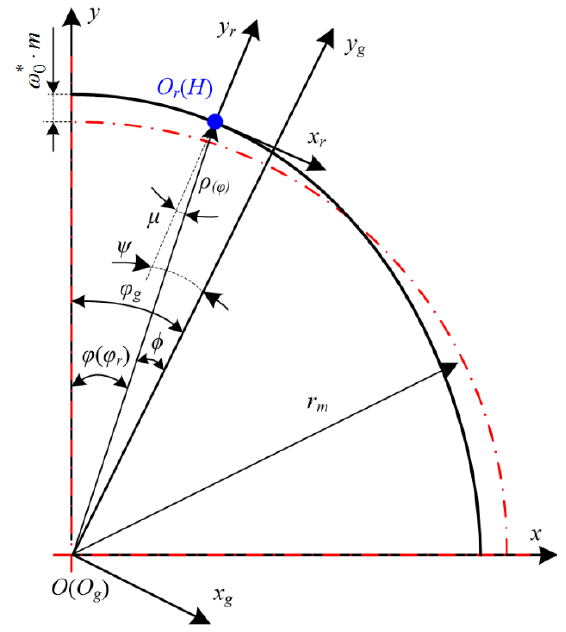
Figure 4. Coordinate system used in calculating the conjugate rigid tooth.